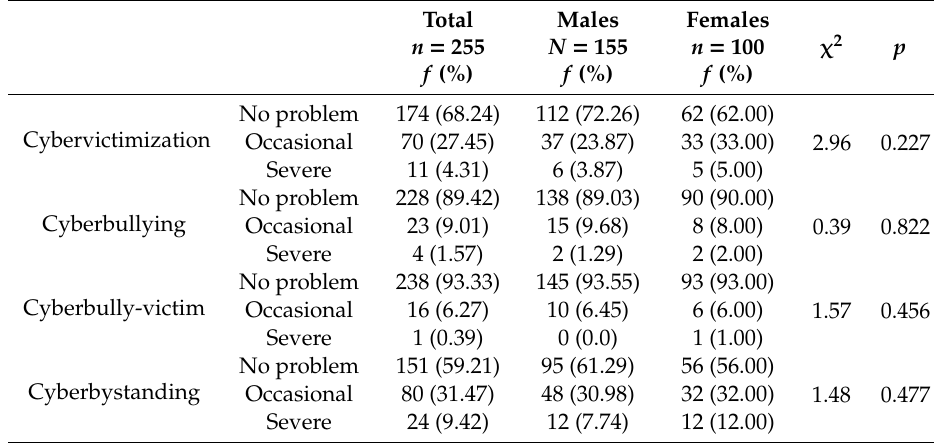
Table 1. Prevalence of cybervictim, cyberbully, cyberbully-victim and cyberbystander profiles according to the categories of no-problem, occasional, and severe problem ( n = 255). Total n =